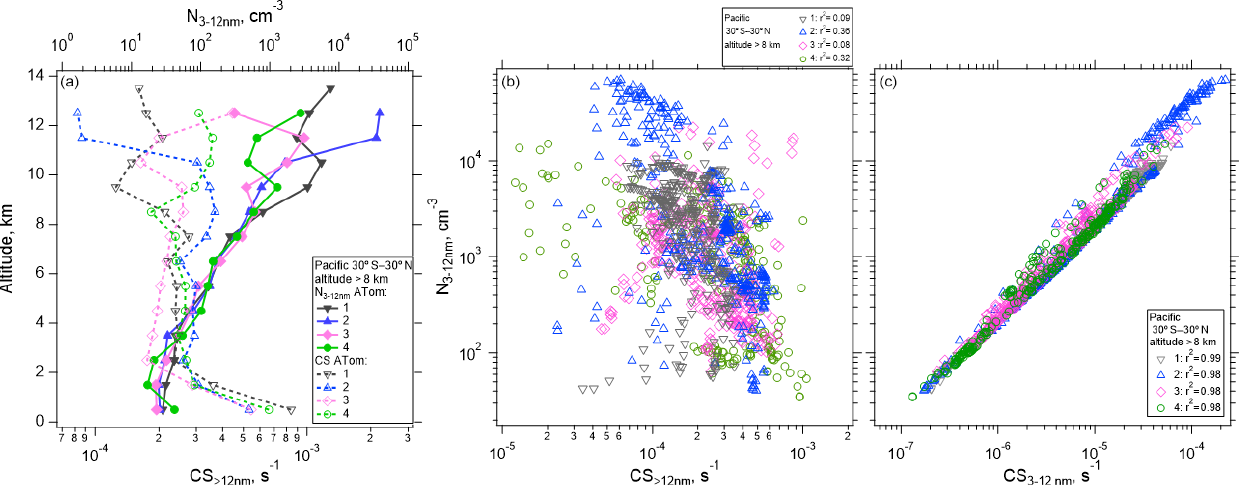
Figure 5. (a) Vertical profile of the median number concentration of nucleation-mode particles (3–12nm) and condensation sink (CS) averaged between 30 ◦ S–30 ◦ N as a function of altitude for the four ATom deployments. (b–c) One-minute average nucleation-mode particle concentrations at > 8km in altitude as a function of CS > 12nm (b) and CS 3–12nm (c) , between 30 ◦ S–30 ◦ N over the Pacific Ocean. Pearson correlation coefficient values ( r 2 ) are indicated in the